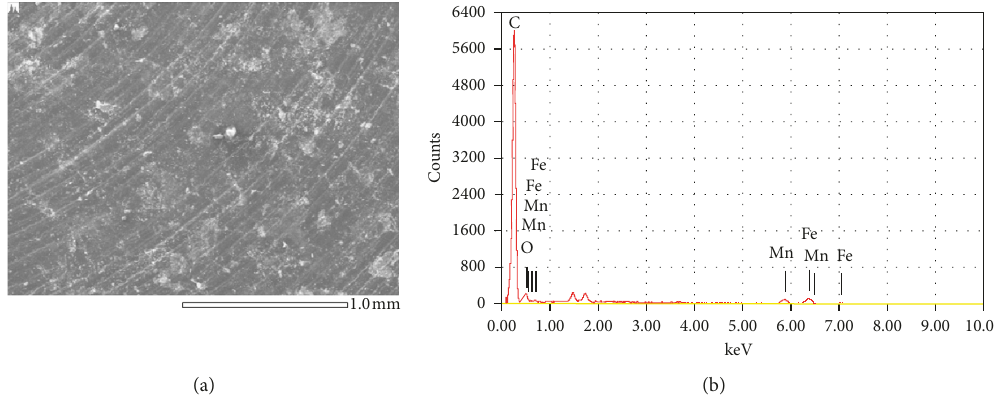
Figure 5: EDS mapping spectrum of EG@MnFe